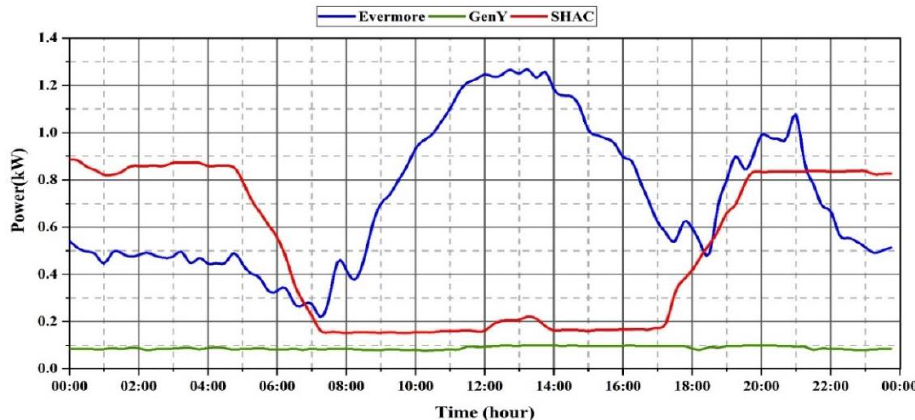
Figure 3. CP diurnal load profile averaged over the period of available data for each site.